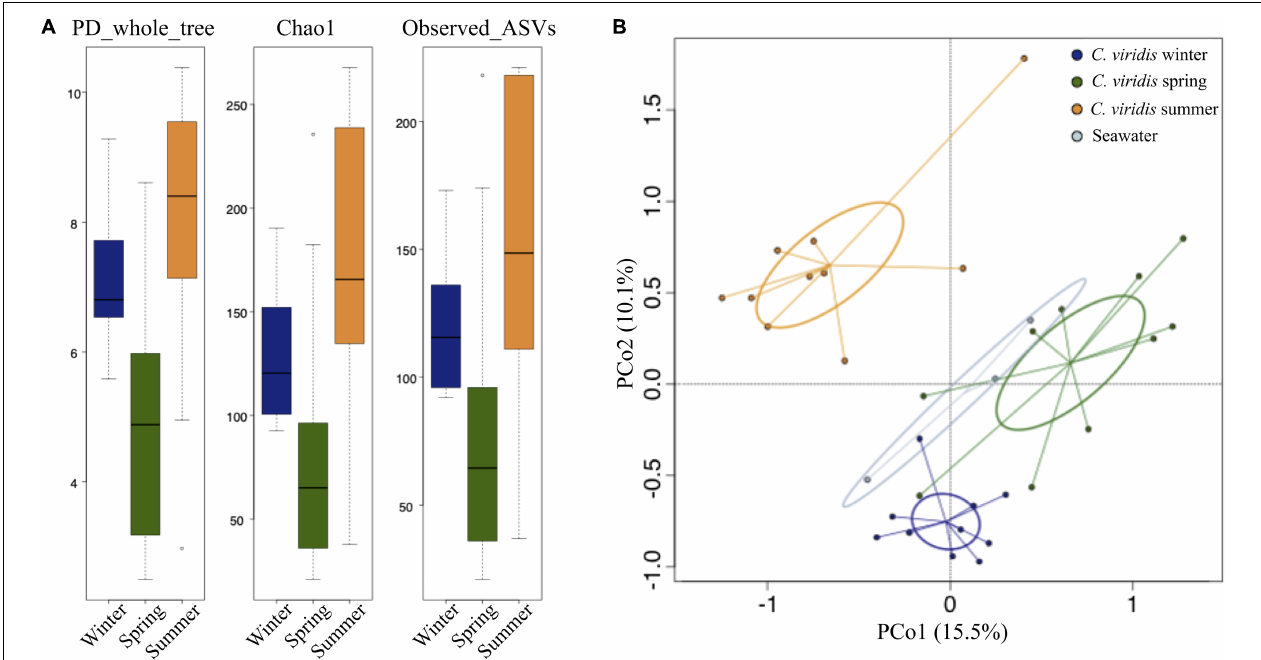
FIGURE 2 | Alpha and beta diversity of the C. viridis microbiota. (A) Box-and-whisker distribution of the Faith’s Phylogenetic Diversity (PD_whole_tree), Chao1 index for microbial richness and number of observed ASVs, calculated for winter (dark blue), spring (dark green) and summer (orange) anemone samples. According to all metrics, greater microbial diversity was observed in winter and summer than in spring (Kruskal–Wallis test controlled for multiple testing using FDR, p -value ≤ 0.05). (B) Principal Coordinates Analysis (PCoA) based on unweighted UniFrac distances showing the variation of the anemone microbiota across seasons (same color code as in A ) and seawater samples (light blue) (permutation test with pseudo F-ratio, p -value ≤ 0.001). The first and second principal components (PCo1 and PCo2) are plotted and the percentage of variance in the dataset explained by each axis is reported. Ellipses include 95% confidence area based on the standard error of the weighted average of sample